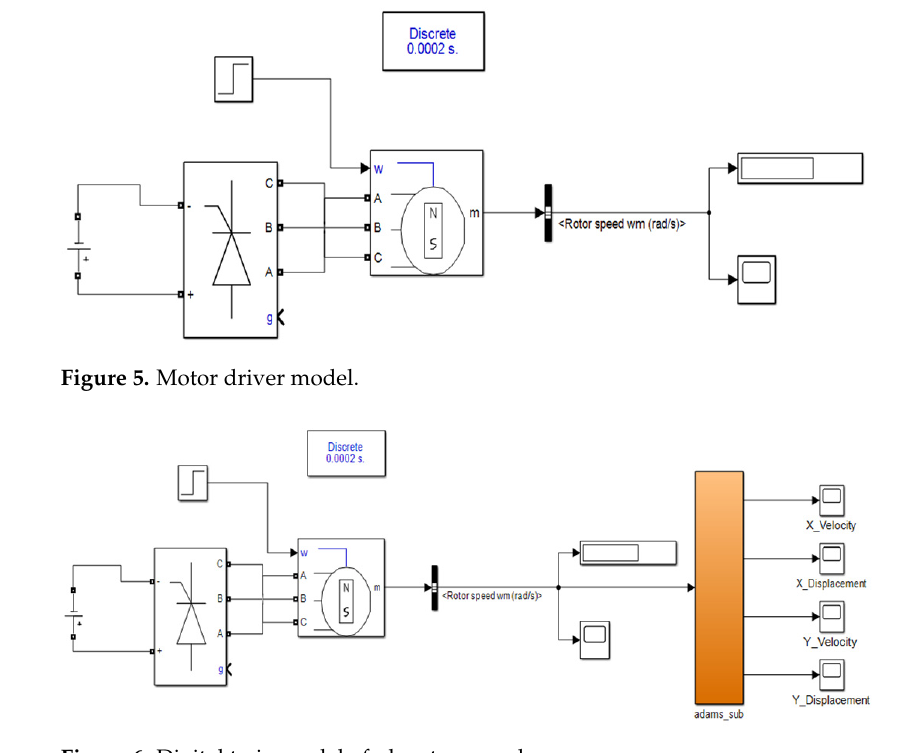
Figure 6. Digital twin model of planetary gearbox.